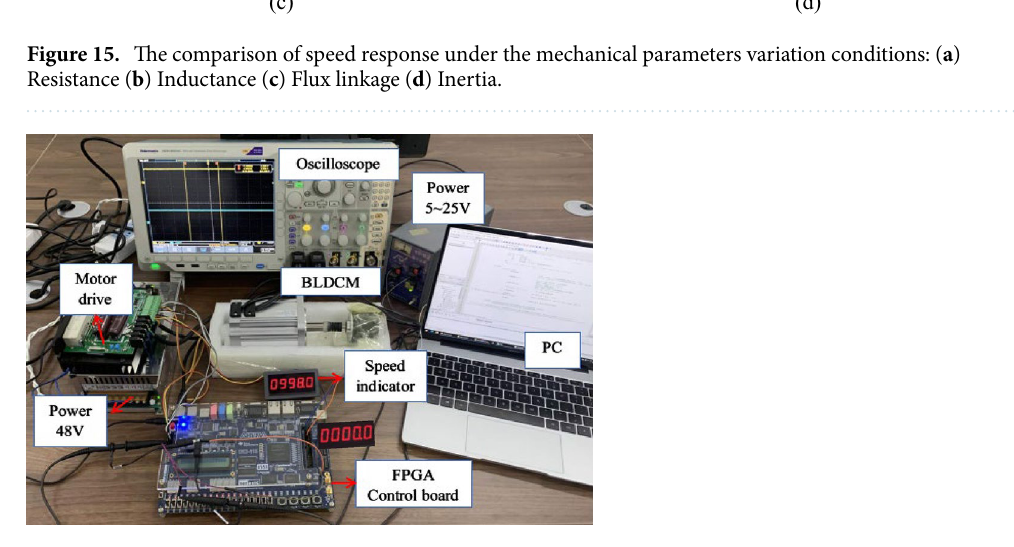
Figure 16. The experimental platform of the BLDCM control